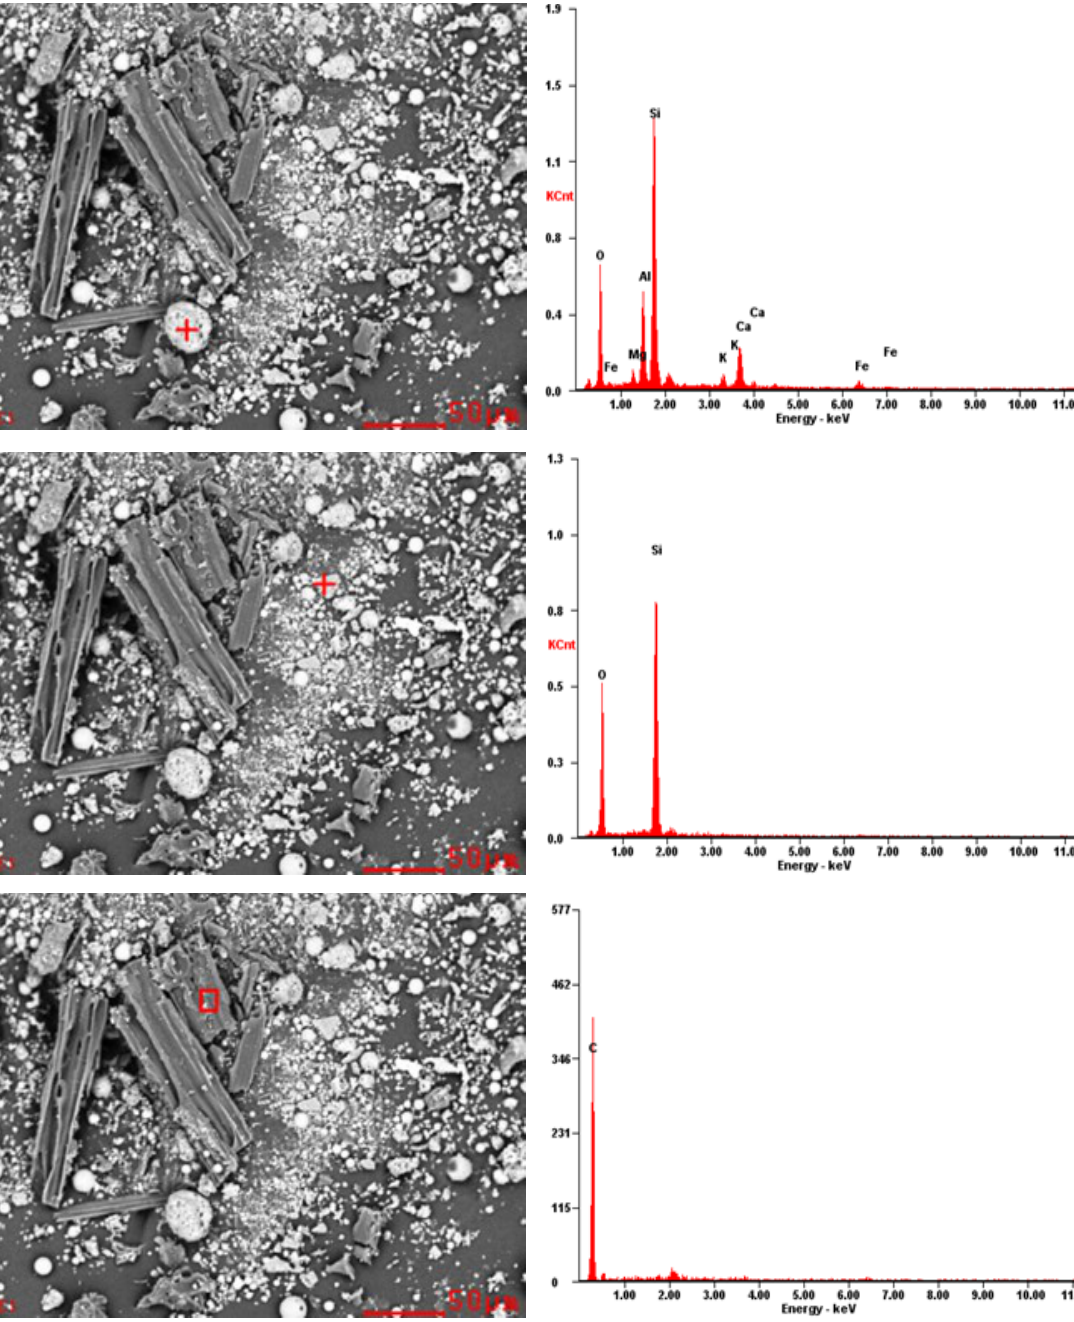
Fig. 5. SEM images and EDX spectra of ashes collected in